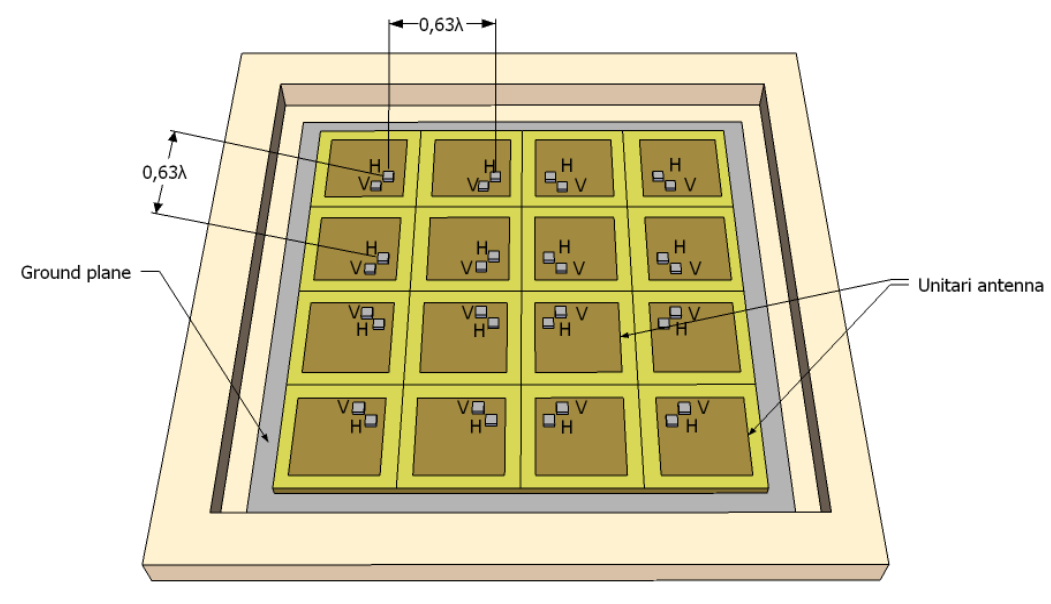
Figure 4. Polarimetric antenna array for the DBF. Using patch rotated antennas and with a distance between elements of 0.63 